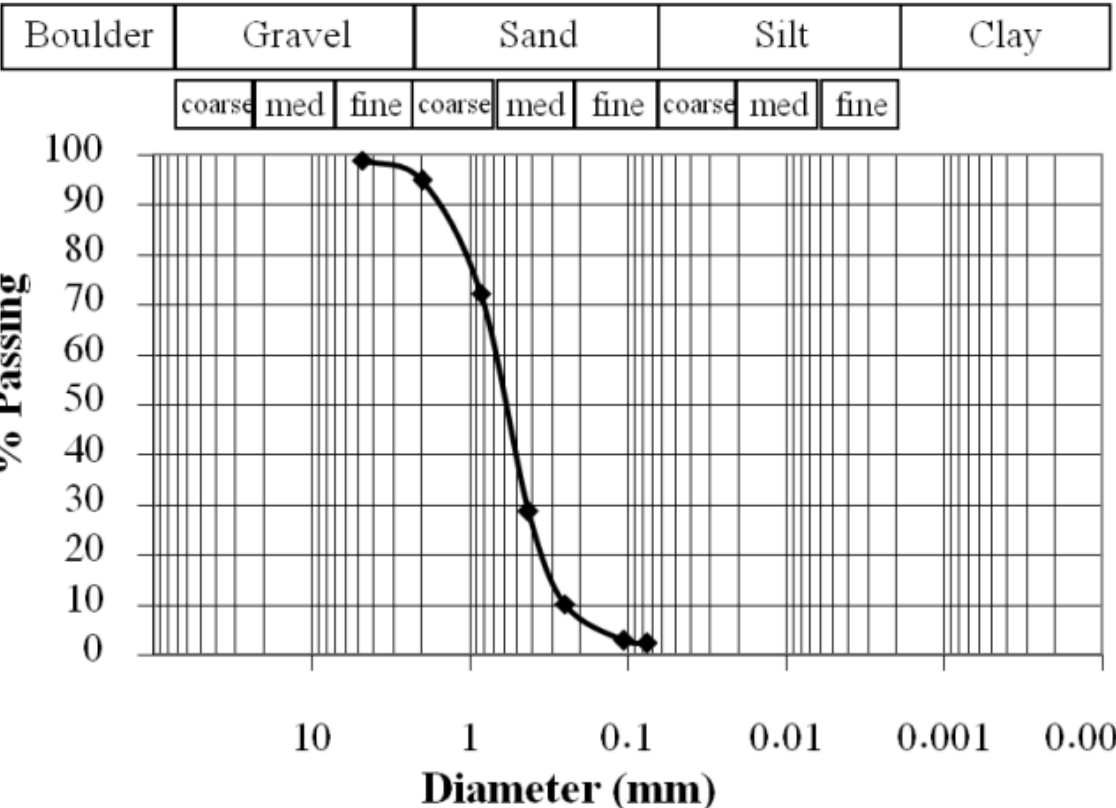
Figure 15. The sieve analysis of specimen 9 at 88.5E km at Sarapum